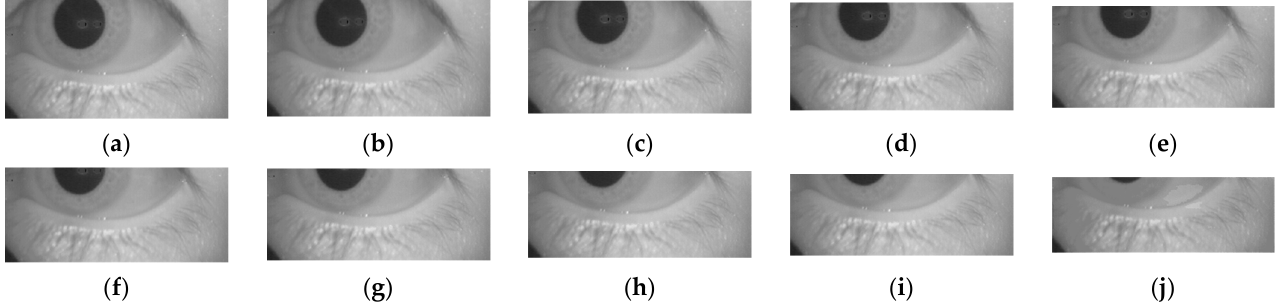
Figure 9. Illustration of pupil cropping: ( a ) 100%; ( b ) 90%; ( c ) 80%; ( d ) 70%; ( e ) 60%; ( f ) 50%; ( g ) 40%; ( h ) 30%; ( i ) 20%; and ( j ) 10%.